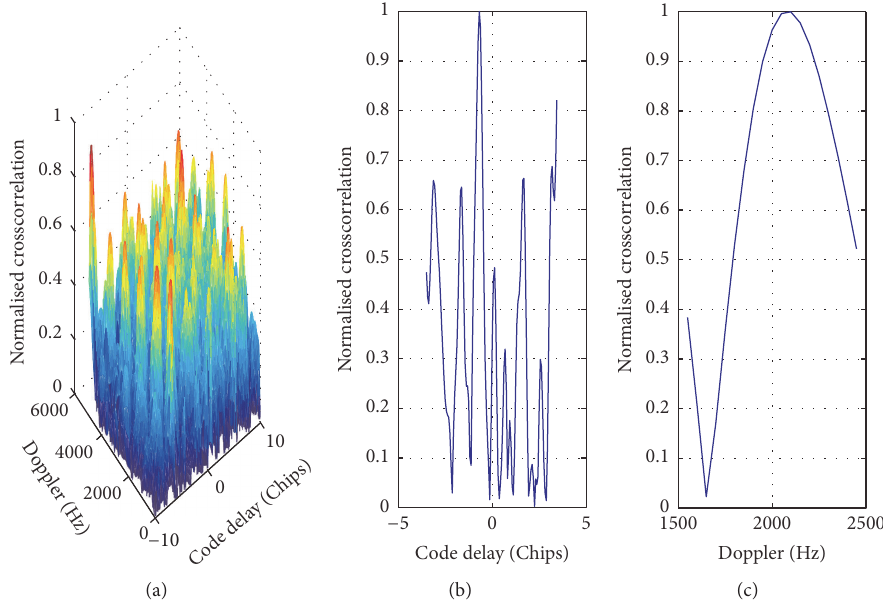
Figure 22: Correlation peaks after interference suppression by DST-MPDR beamformer for scenario 3.